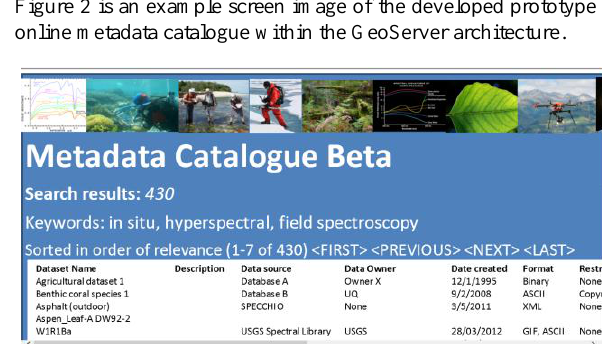
Figure 2 A screen image of the prototype metadata catalogue with search results